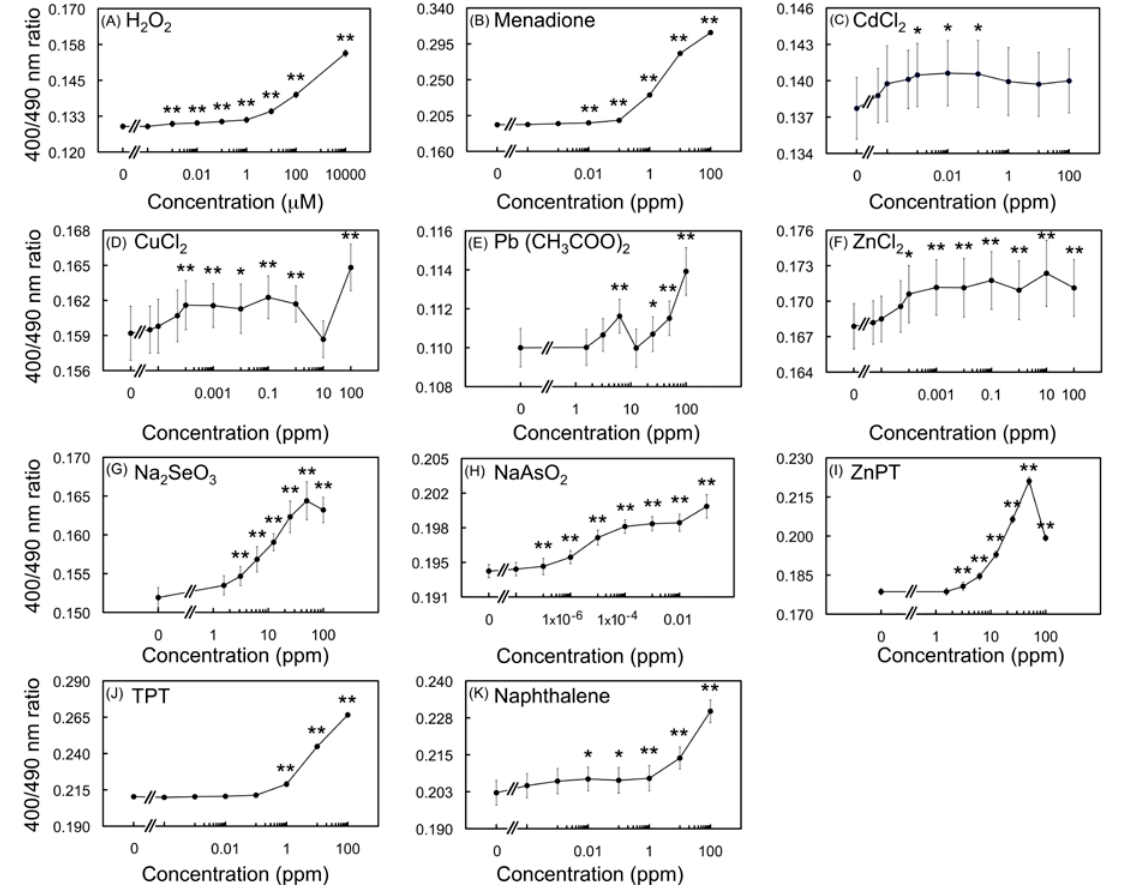
Figure 4. Concentration-response curves as shown by fluorescent ratiometric changes. Exposure to several concentrations of H O (A), menadione (B), CdCl 2 2 (D), Pb(CH COO) (E), ZnCl (F), Na SeO (G), NaAsO (H), ZnPT (I), TPT (J) 3 2 2 2 3 2